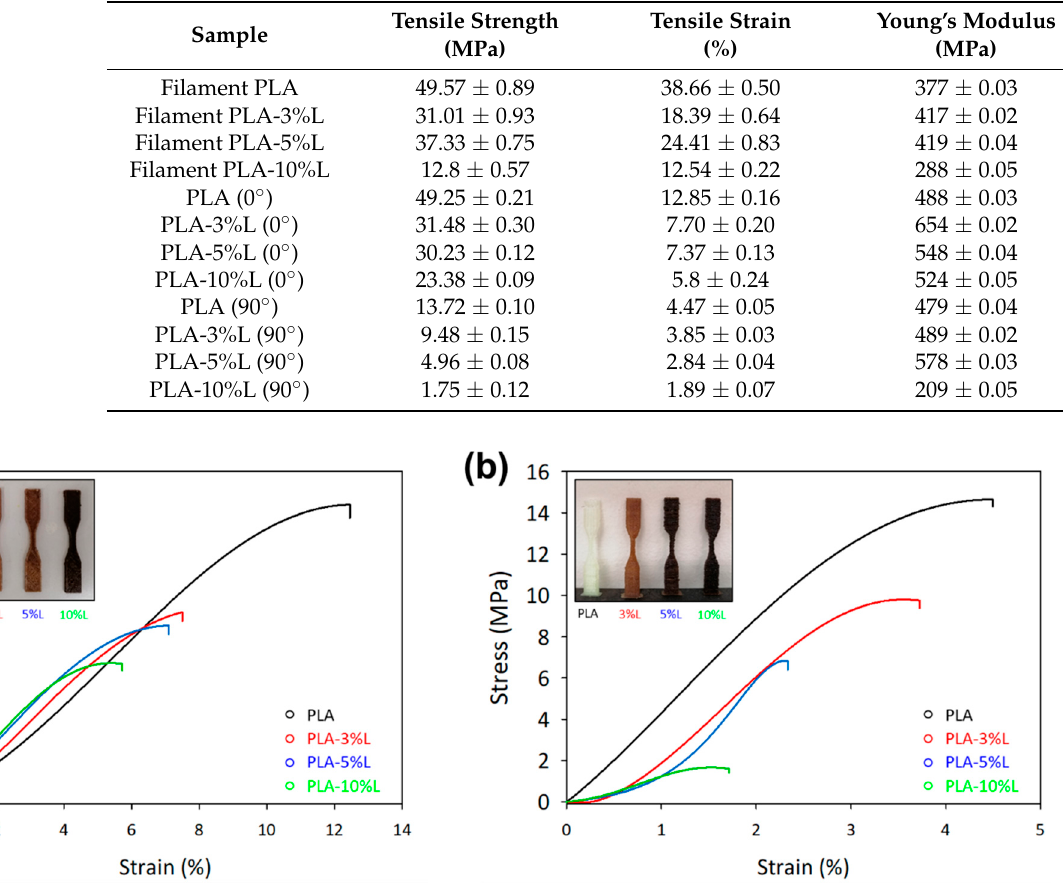
Figure 4. Mechanical strength of the 3D printed product of neat biopolymer and biopolymer com- posites at different ( a ) horizontal (0°) and ( b ) vertical (90°) orientations . Subset images show the 3D printed product as a comparison. Table 2. Mechanical properties of extruded filaments and 3D printed PLA and PLA incorporated with lignin at different horizontal (0°) and vertical (90°) orientations .